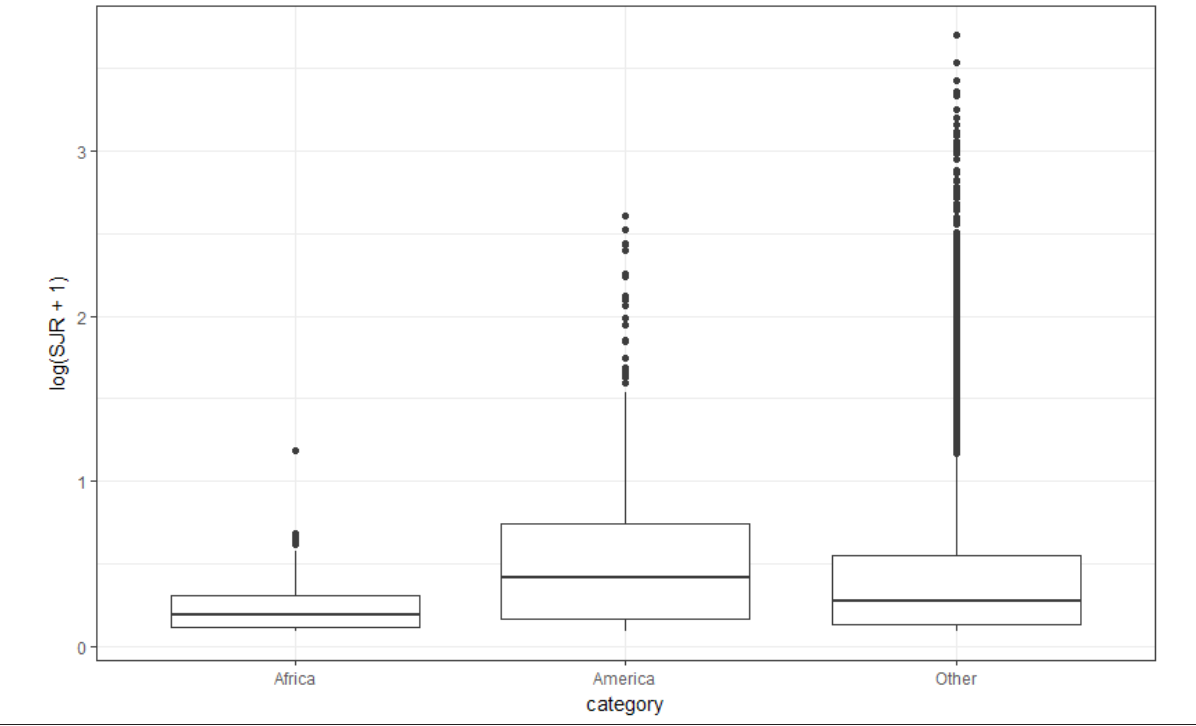
Figure 1: Box plots of log-transformed SJR scores for different journal categories: those containing ‘Africa’ in the title; those containing ‘America’ in the title, and the group of other journals. Journals with ‘African American’ in their titles ( n =4) are included in the ‘Africa’